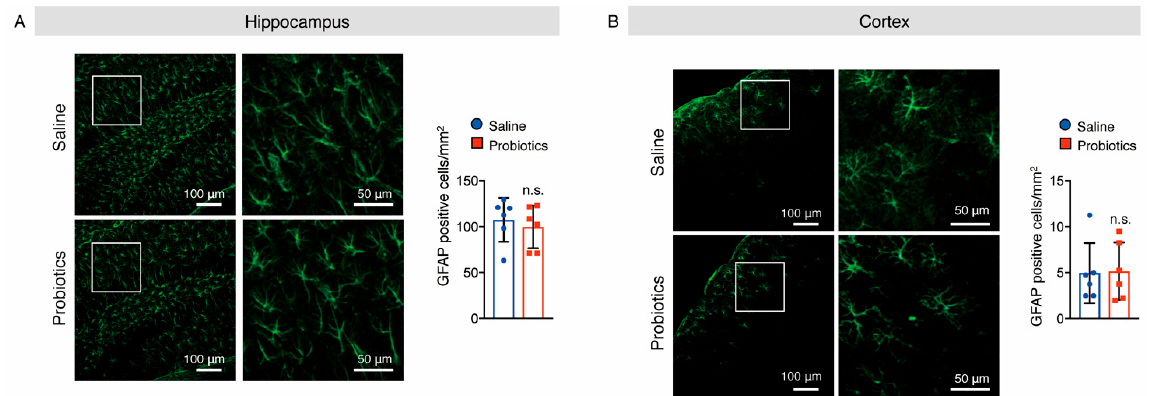
Figure 8. Oral supplementation of B. breve MCC1274 does not affect astrogliosis in the brain of WT mice. GFAP immunostaining in the hippocampus ( A ) and cortex ( B ) of WT mice. Representative images of brain sections stained with an anti-GFAP antibody (green) and DAPI nuclear counterstain (blue) (left panel). The number of GFAP + cells in the hippocampus ( A ) and cortex ( B ) (right panel). Data are represented as mean ± SD, n = 6 per group; n.s. no significant difference compared with the saline group, as determined by Student’s t -test.